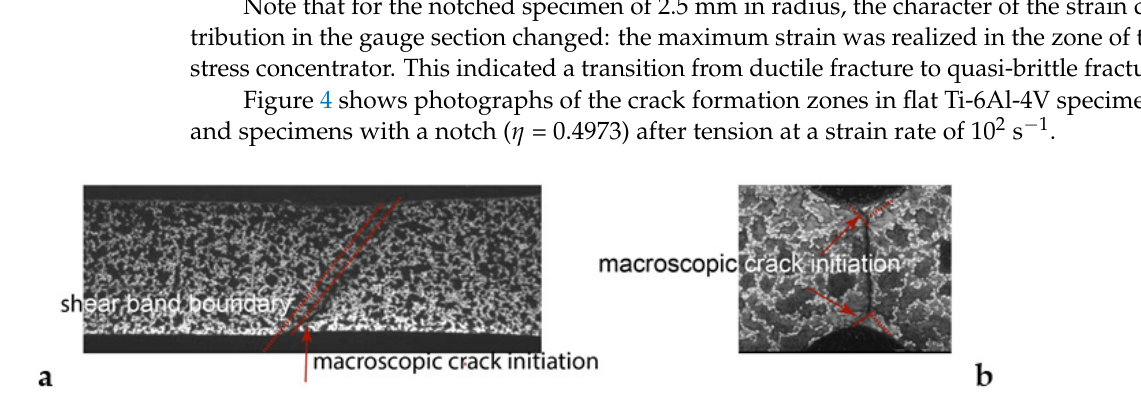
Figure 4. Crack in a smooth specimen after tension at a strain rate of 10 2 s − 1 ( a ), crack in a notched specimen ( b